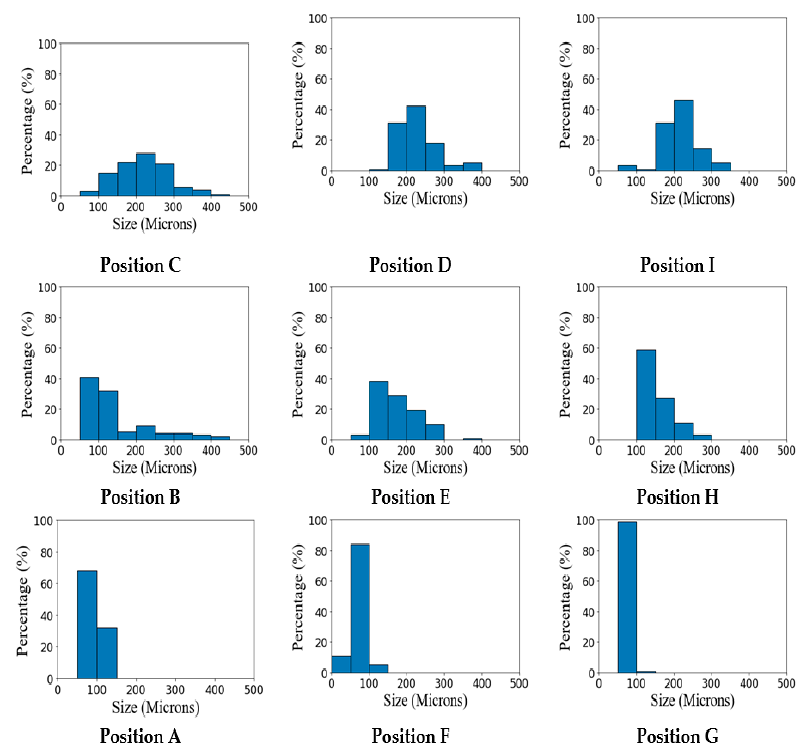
Figure 10. Distribution of the bubble size at 9 sampling positions.